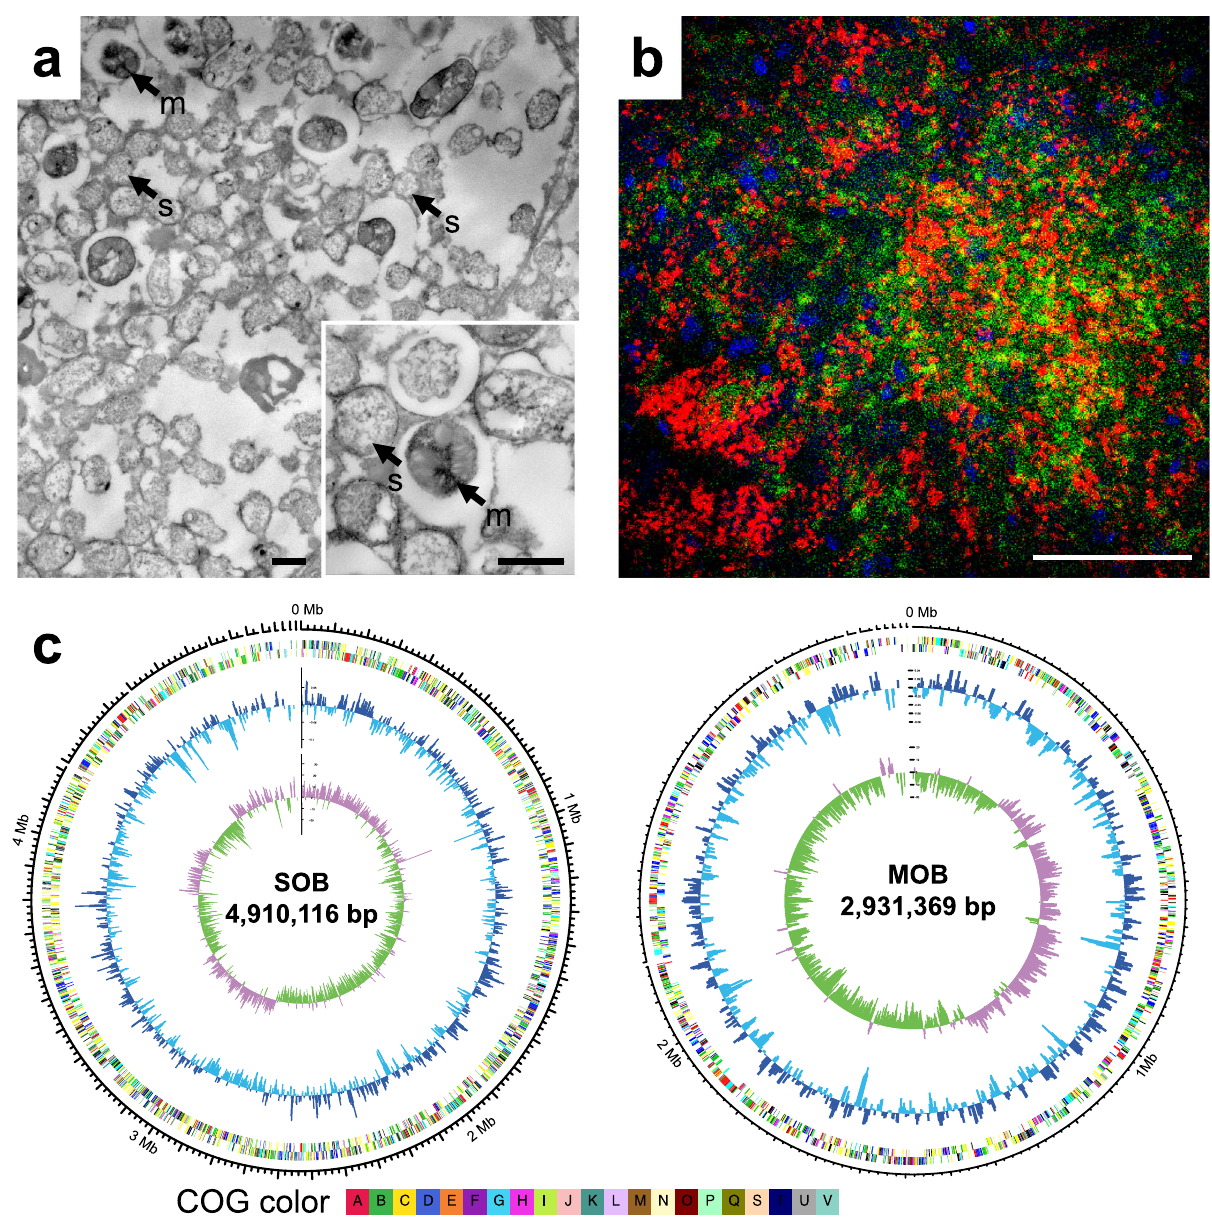
Fig. 2 Dual symbionts of Gigantopelta aegis snail. a Transmission electron microscopy (TEM) images of intracellular endosymbionts showing two distinct morphological types: one endosymbiont with intracellular stacked membranes (black arrows; m: methane-oxidising symbiont) and another without (black arrows; s: sulfur-oxidising symbiont; scale bar: 1 µ m). b Fluorescence in situ hybridisation (FISH) image yielding signals of sulfur-oxidising endosymbionts (SOB; Cy3: green) and methane-oxidising endosymbionts (MOB; Cy5: red) on transverse sections of the oesophageal gland from Gigantopelta aegis (scale bar: 50 µ m). Host nuclear DNA with DAPI staining is blue. More detailed TEM and FISH images are shown in Supplementary Fig. 2. c Key genome features of both the SOB and the MOB of G. aegis with genome sizes in the centre, the inner circle showing the GC skew (minus value: green value, plus: purple), the second circle showing the GC content of the deviation from the average (SOB: 39.93%; MOB: 45.26%; lower than average GC content: light blue, higher than average: dark blue), and the outer circle showing the COG annotation categories with different colours. The details of COG annotation are shown in Supplementary Data 3 and 4. A sliding window of 5 kb in a step of 2.5 kb was applied in the calculation of both the GC skew and the GC content. TEM experiments were applied on three individuals with more than three thin sections each. FISH experiments were repeated independently for twice and at least ten sections of the samples were used for each time. These experiments were repeated with similar results. The description of COG annotation categories are provided in Supplementary Fig.